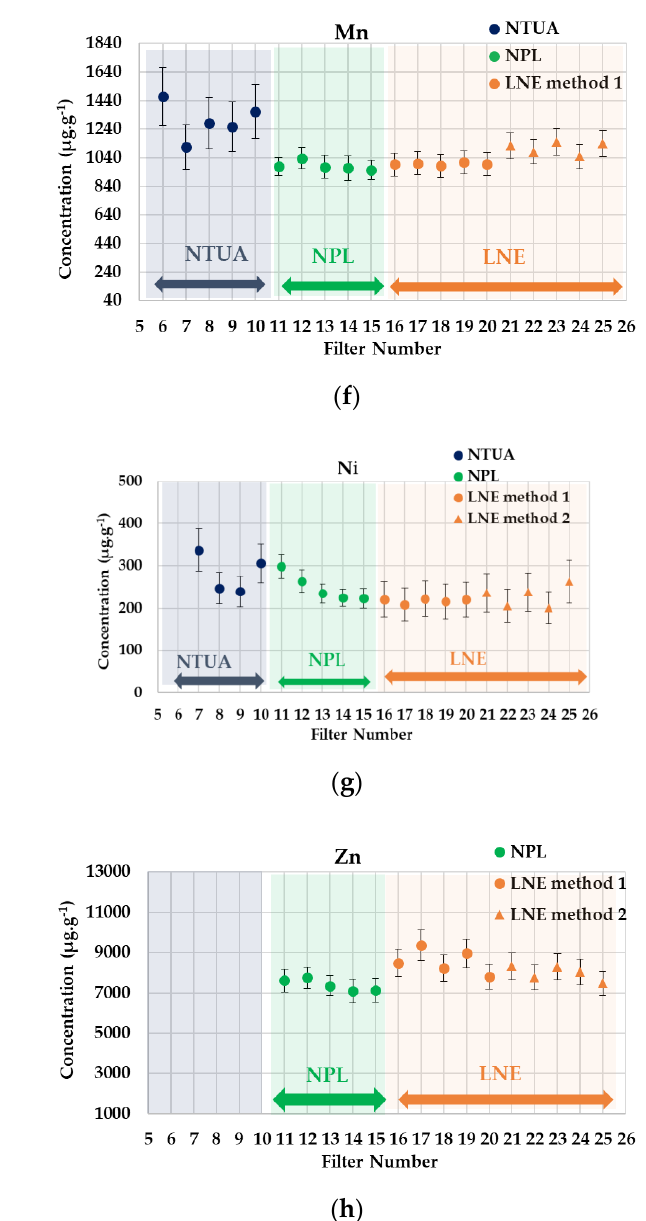
Figure 3. Inductively Coupled Plasma–Mass Spectrometry (ICP-MS) intercomparison results for particulate matter PM 10 - loaded filters. ( a ) Cr, ( b ) Fe, ( c ) Cu, ( d ) As, ( e ) Pb, ( f ) Mn, ( g ) Ni, ( h ) Zn and ( i )